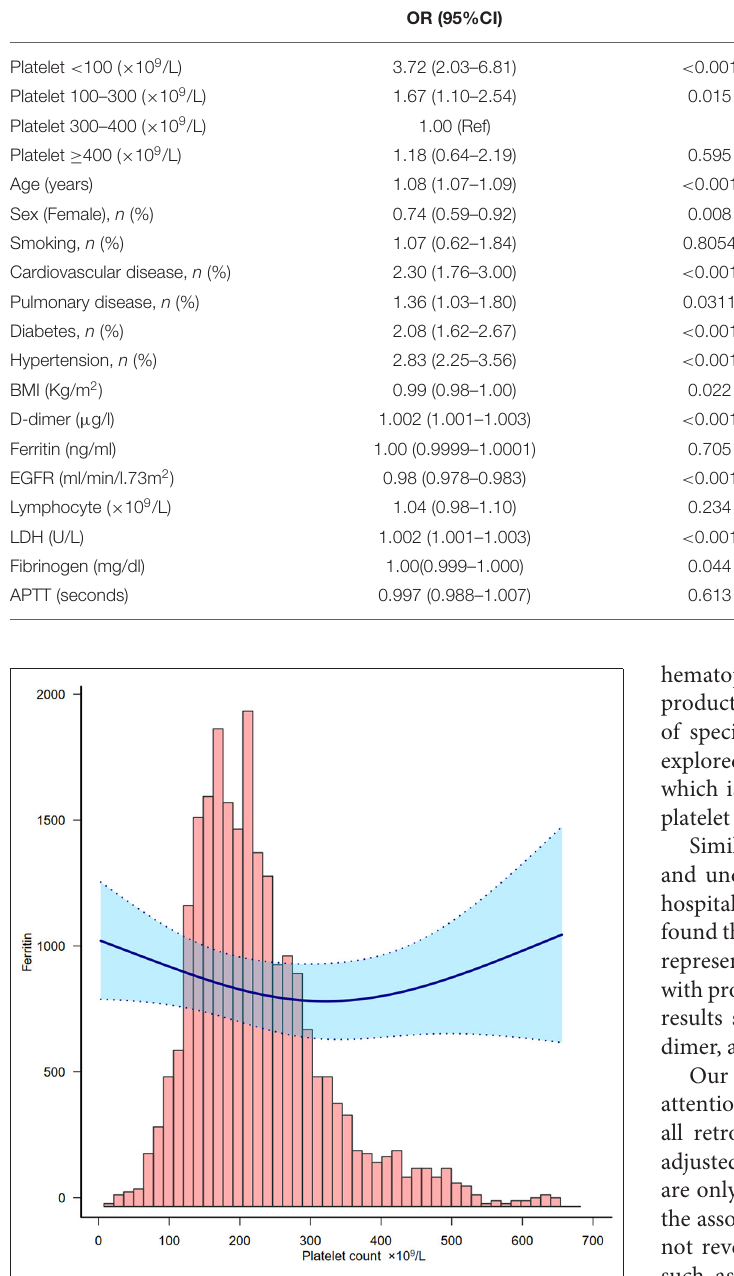
TABLE 4 | Univariate logistic and multivariable logistic regression models evaluating the association between platelet count and in-hospital mortality. Variable